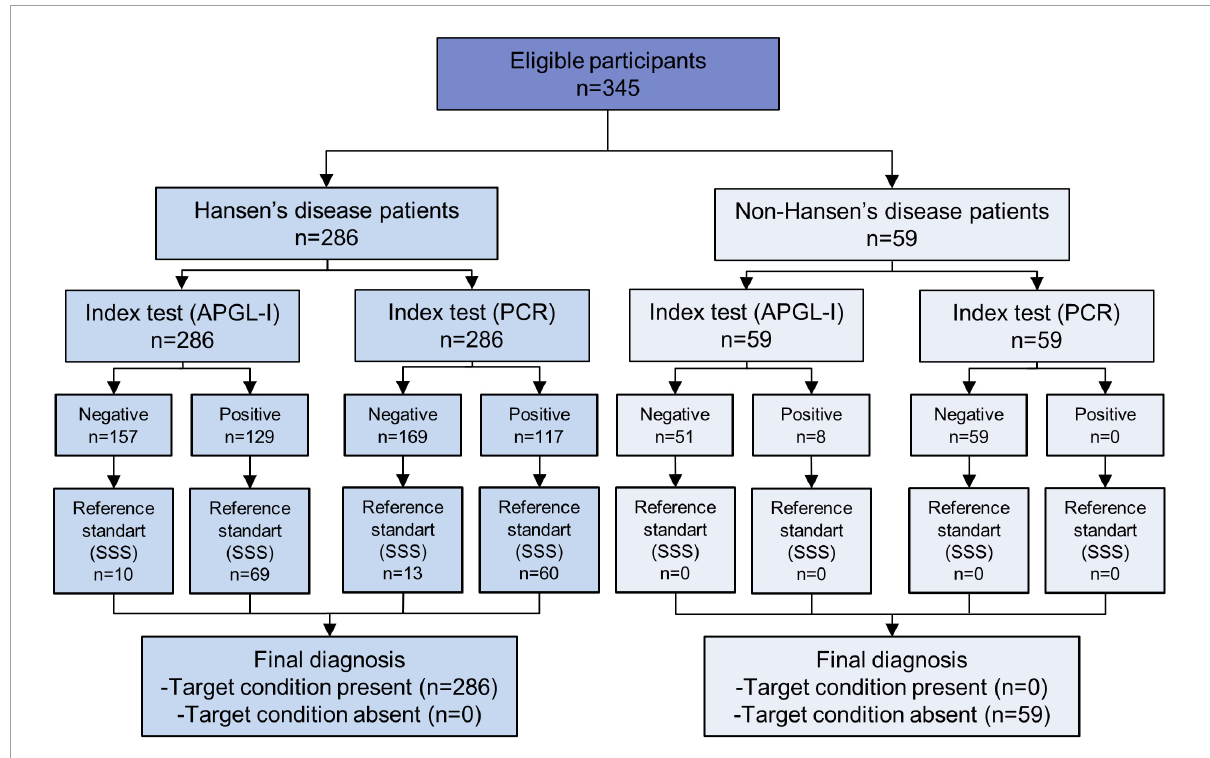
FIGURE1 STARD diagram to report flow of participants through the study.